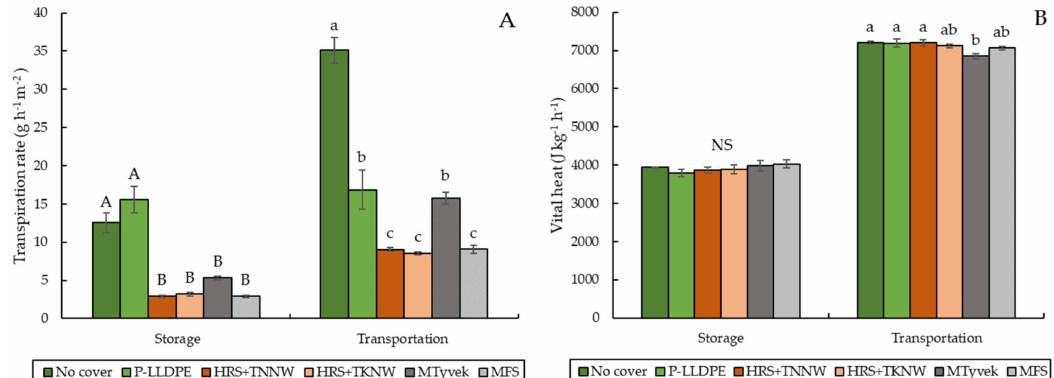
Figure 10. Transpiration rate ( A ) and vital heat ( B ) among the six treatments during simulated storage at 18 ◦ C for 48 h and simulated transportation at 30 ◦ C for 15 h. Different letters indicate significant differences at p < 0.05. Values are mean ± S.E. from five